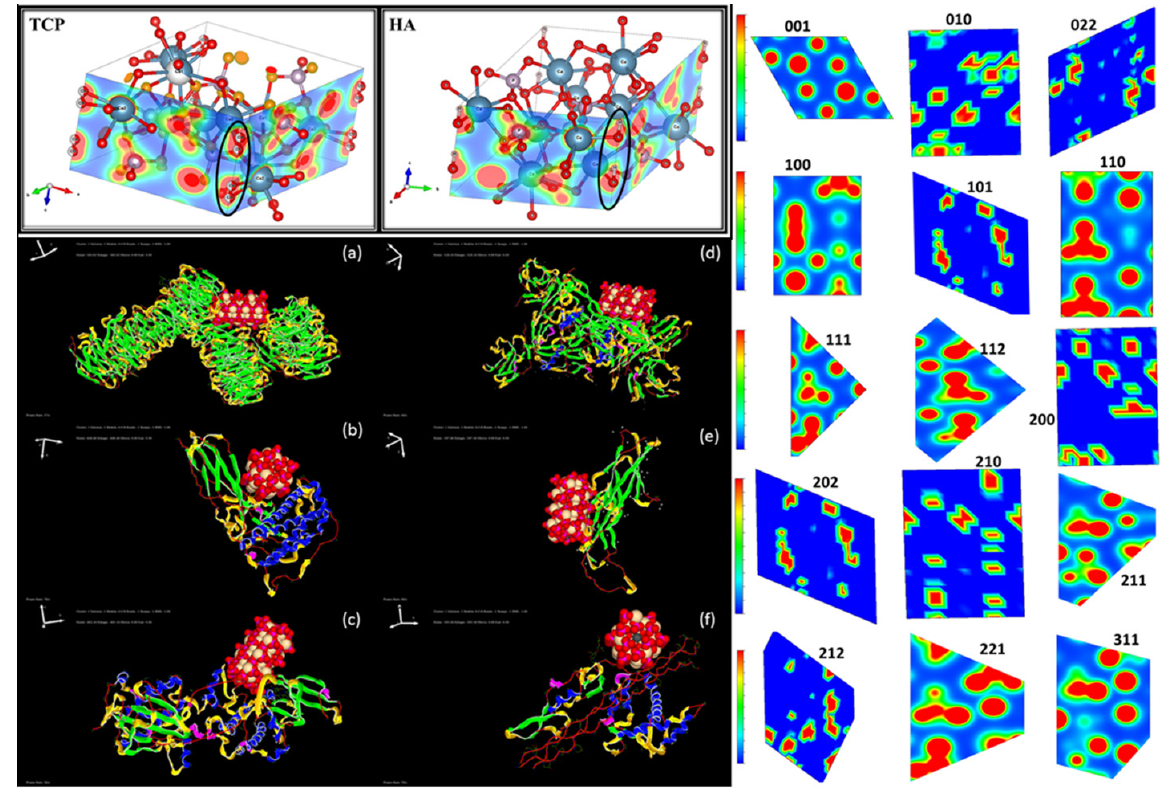
Figure 8: (clockwise) The electron density of the TCP versus HA, the electron density map of the different symmetric planes of the optimized HA crystal, and the best docking poses of the interaction of the HA 001 plane (ball model) with the various proteins (ribbon model) noted in the different stages of the bone cell growth